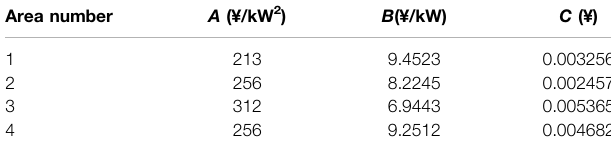
TABLE 3 | Power generation cost coef fi